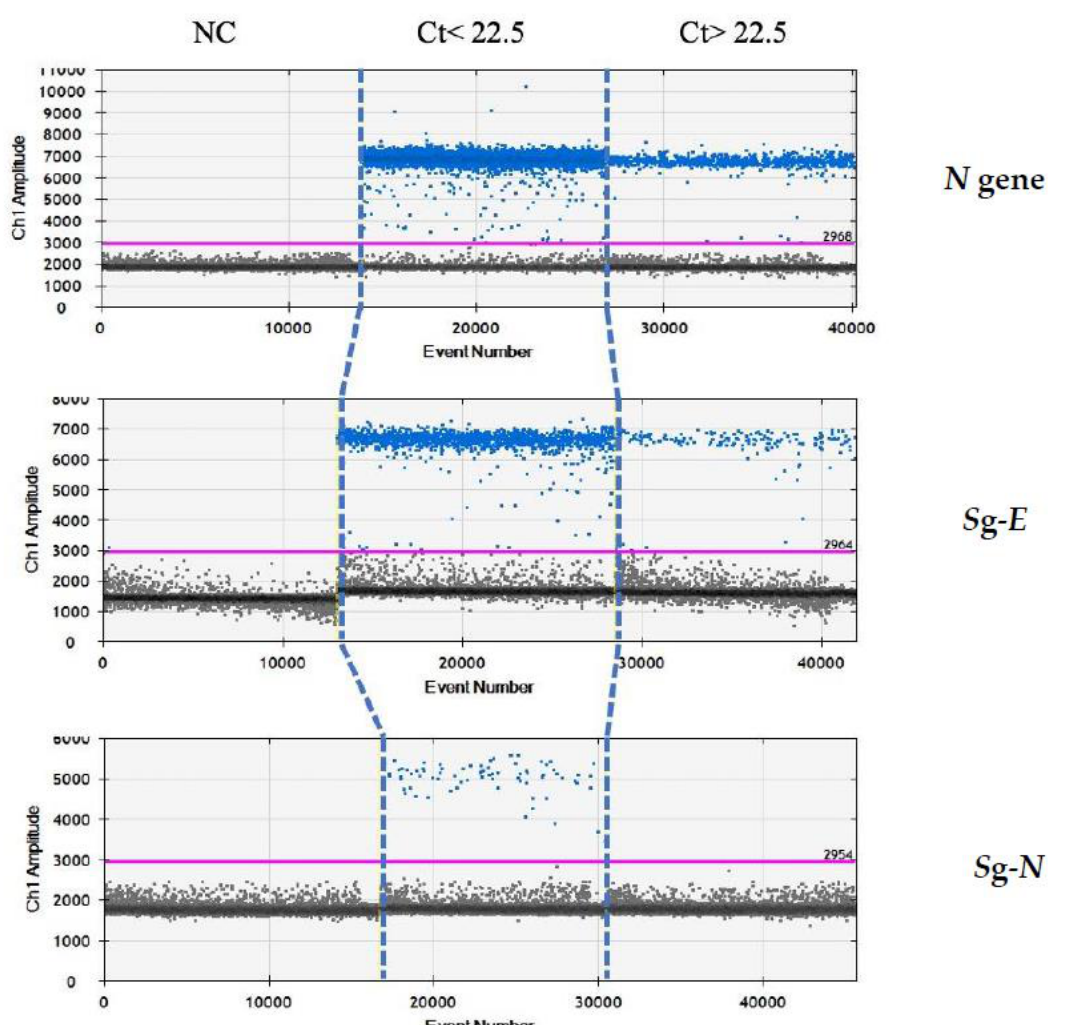
Figure 3. Analysis by ddPCR analysis on samples with low Ct ( ≤ 22.5) for N , sgE and sgN transcripts . ddPCR analysis output regarding samples with either Ct ≤ 22.5 or Ct > 22.5 in the realtime PCR analysis. Gene N is present in all of the samples with Ct below or above the 22.5 value. The sgN RNA is only detectable for Ct ≤ 22.5, while the sgE transcript is within all of the of the Ct ranges.